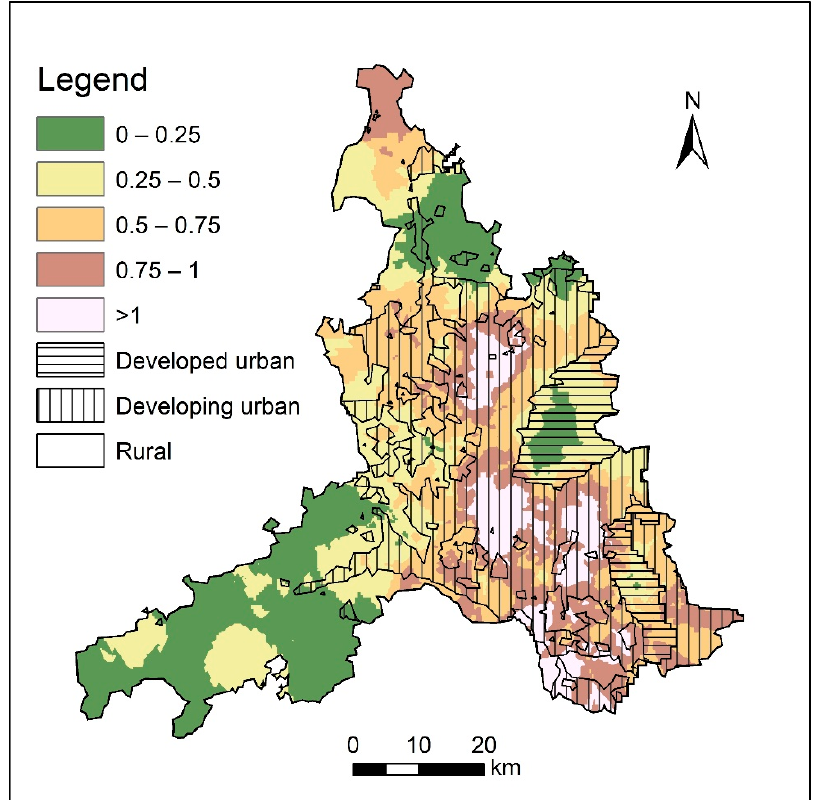
Figure 13. Spatial distribution and zoning of spatial response index.